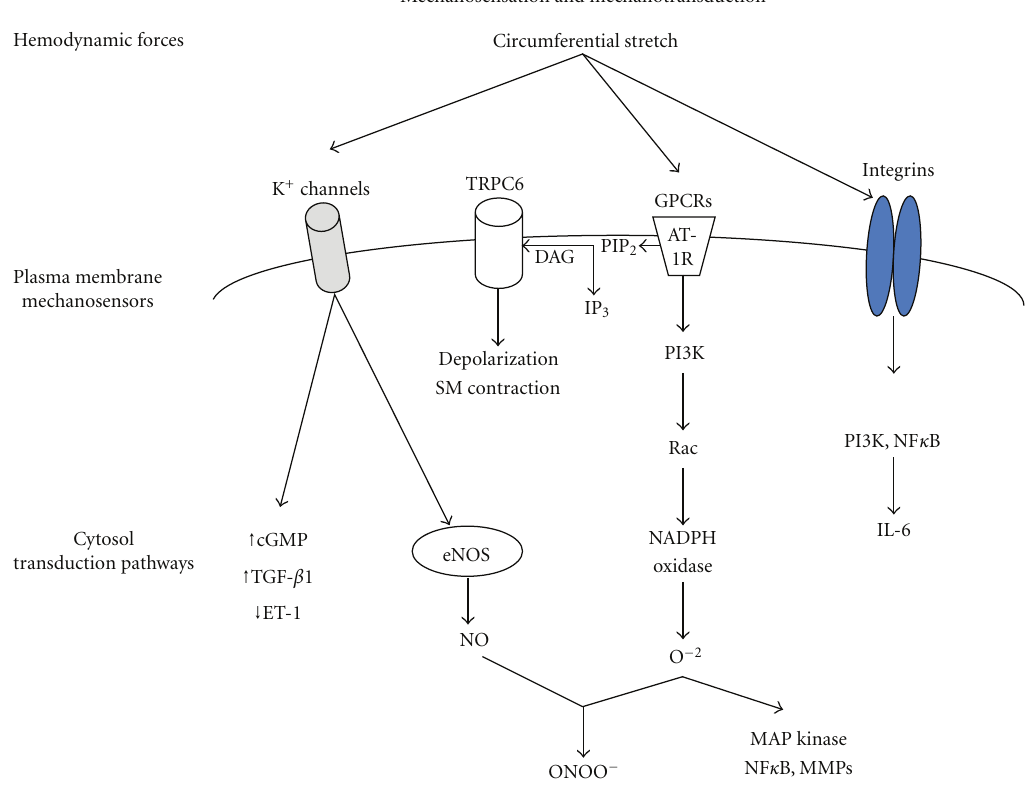
Figure 2: Mechanosensors of circumferential stretch in ECs. Information is compiled for both arterial and venous ECs due to scarcity of studies on venous ECs. Not all ion channels are included. This illustration is not drawn to